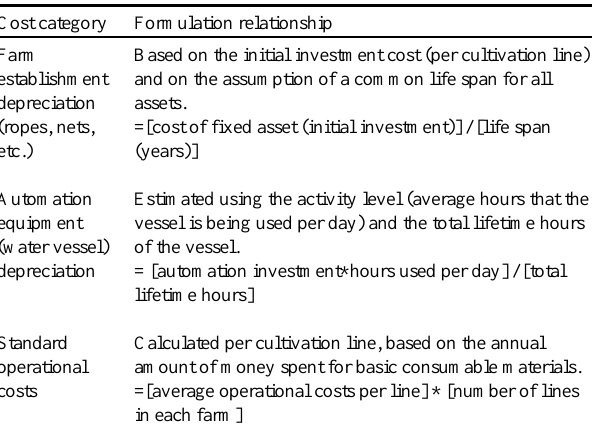
Table 4 . Descriptions and definitions of the cost categories used to define the total costs of a mussel farm